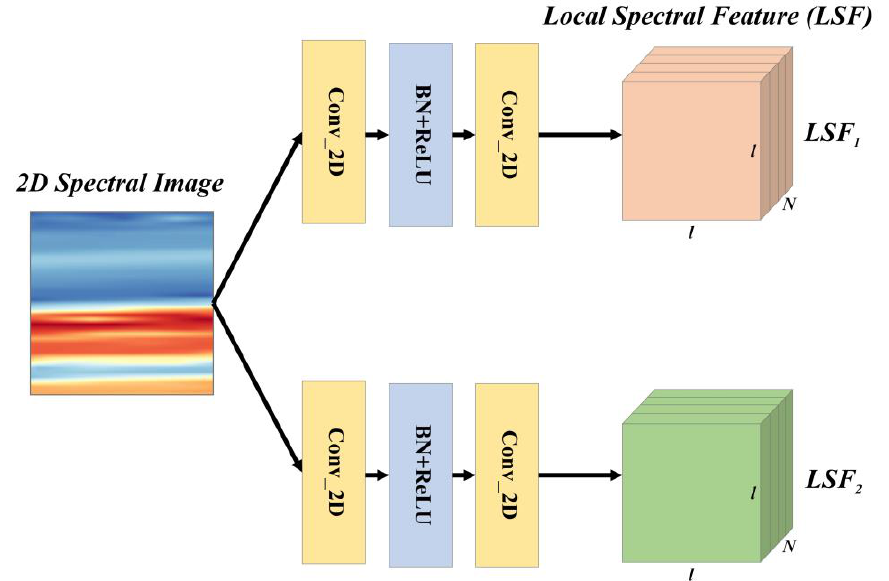
Figure 3. The architecture of the LSFEM. The input of the LSFEM is the 2D spectral image and the output of the LSFEM is two LSF groups.